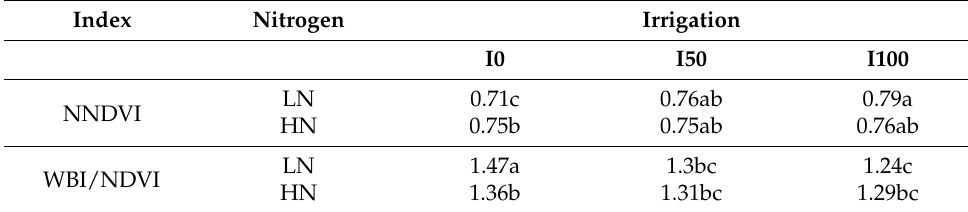
Table 3. The effect of the interaction of irrigation x nitrogen on the vegetation